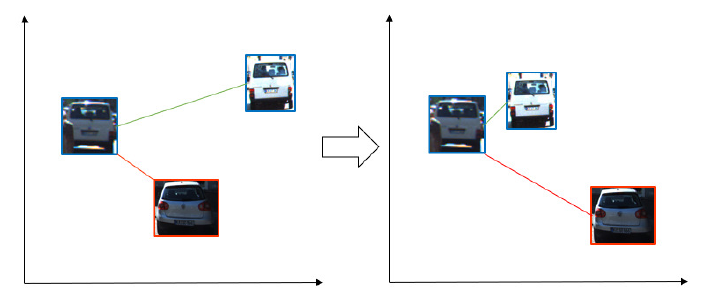
Figure 7. Schematic of the triplet structure of the proposed network.